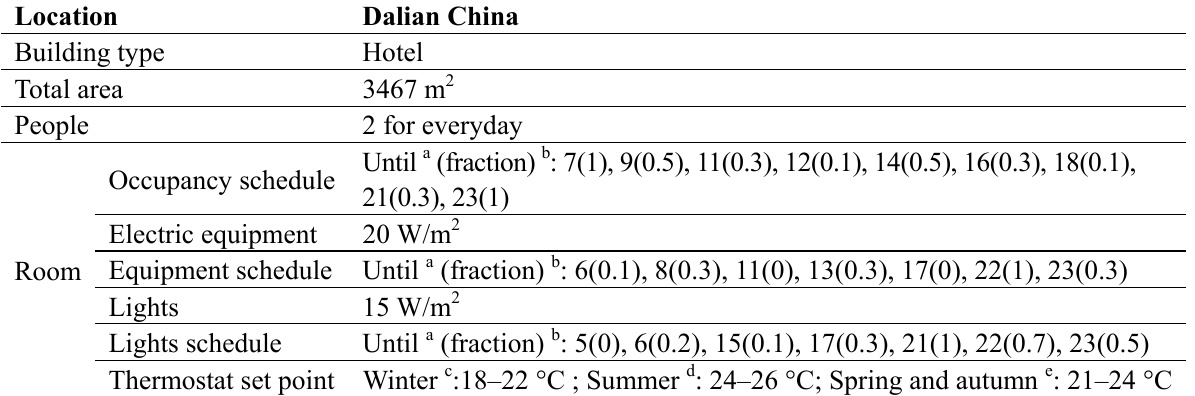
Table 1. General descriptions of the simulated building using DeST software.